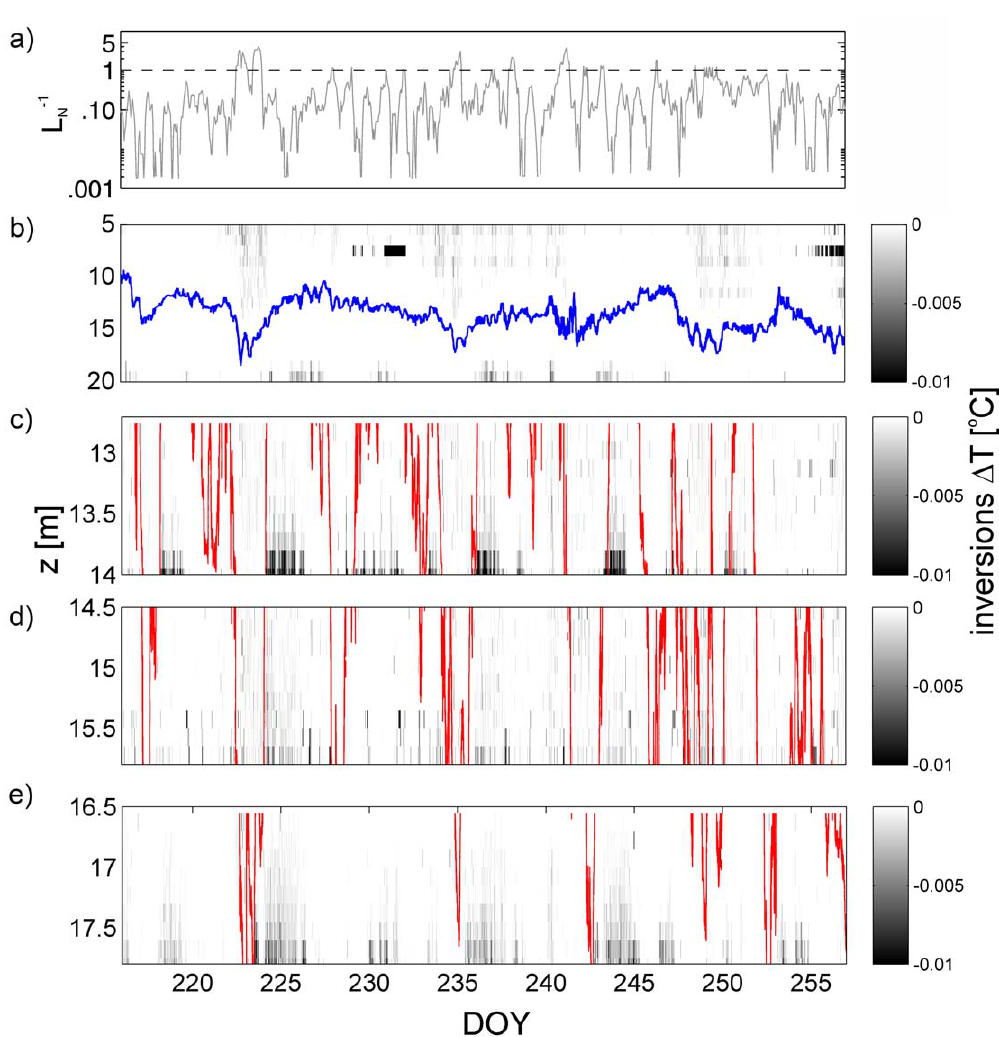
Figure 4. Observed temperature inversions in the water column. a) Inverse of the estimated Lake number L N . b) Inversions at C1 mooring. Note that the blue line represents the position of the thermocline at the thermistor chain. c) Inversions at T1. d) Inversions at T2. e) Inversions at T3. The red line reflects the local 16 u C isotherm (local thermocline) for each benthic thermistor chain.